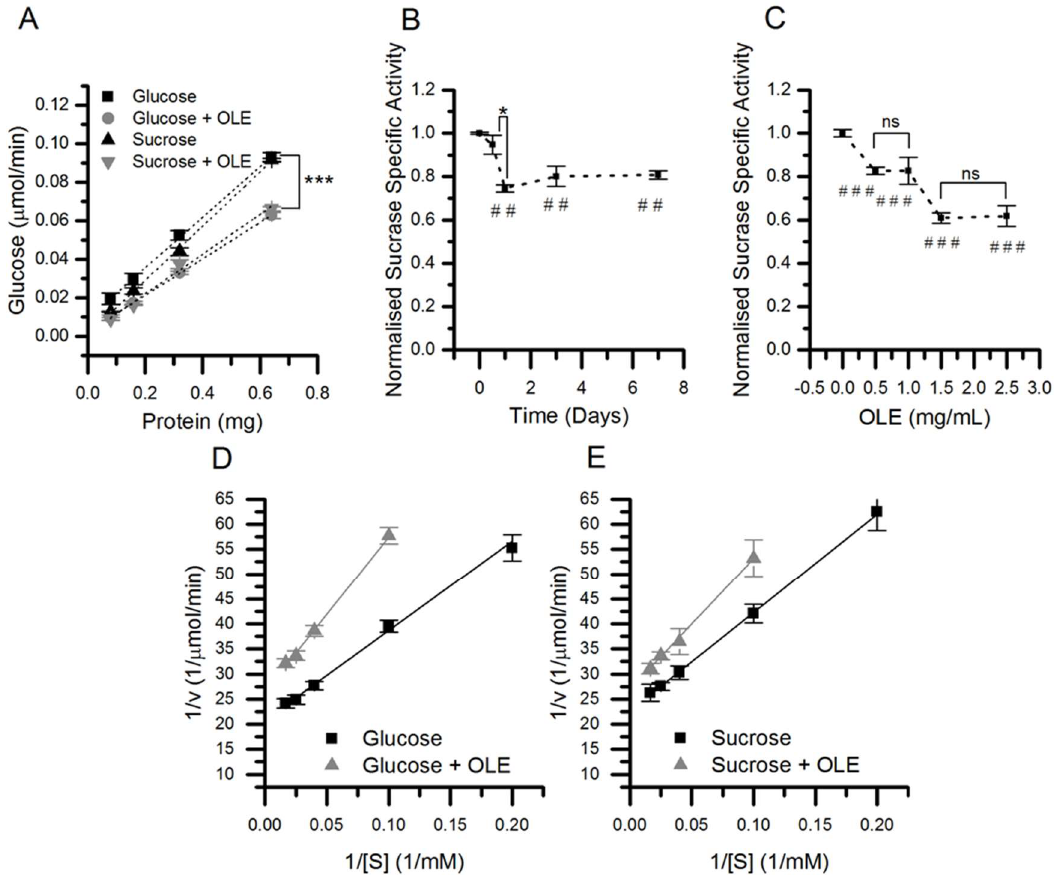
Figure 4. The effect of chronic OLE on sucrase enzyme kinetics. Caco-2/TC7 cells were cultured in 25 mM glucose or 25 mM sucrose for 21 days and treated for the final 3 days with 1.5 mg/mL OLE. Sucrase specific activity was determined ( A ) and the linear slope represents the enzyme activity in µmol/min.mg ( n = 9, *** p < 0.001). The sucrase specific activity was evaluated up to 7 days ( B ) and at 0.5, 1, 1.5 and 2.5 mg/mL OLE ( C ). ( n = 6, p <0.001 compared to control, * p < 0.05, ns = not significant). The effect on K m and V max after 3 days treatment at 1.5 mg/mL was determined by Lineweaver–Burk plots for cells cultured in glucose ( D ) and sucrose ( E ) ( n = 9). All data presented as mean ± SEM.